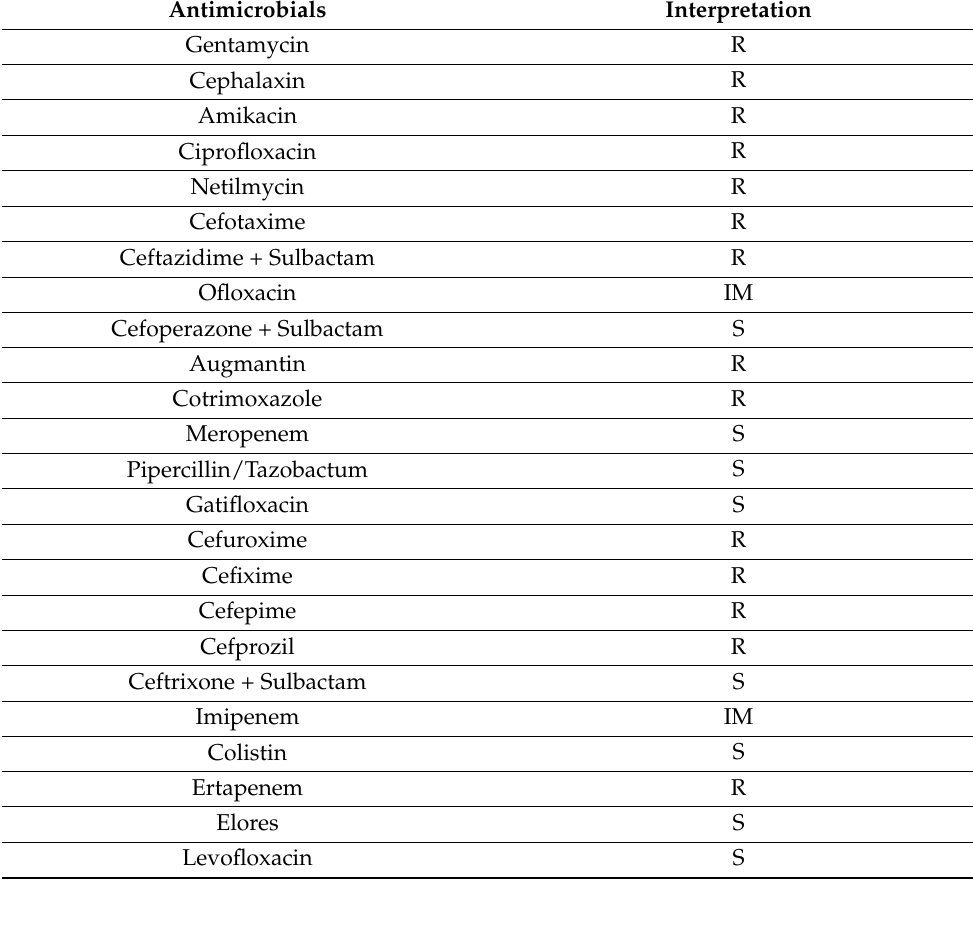
Table 1. Antibiogram profiling of Acinetobacter lwoffi showing sensitivity to various antibiotics (R—resistant; S—sensitive; IM—intermediate).